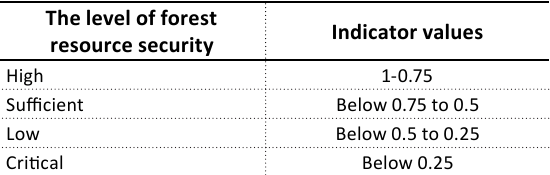
Table 2. The interval scale of the enterprise ecological security